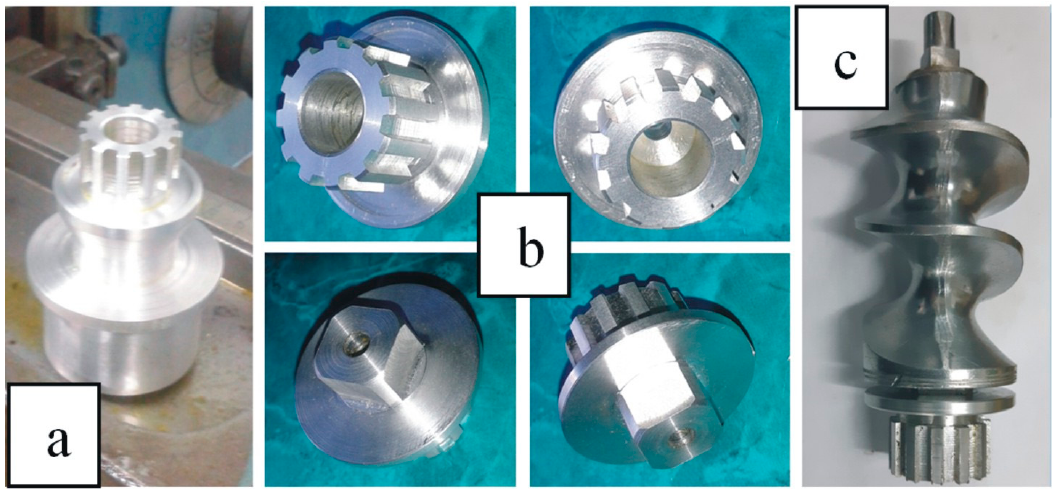
Figure 9. The piece after mortising ( a ), in four hypostases—the finished piece ( b ), the part-mounted piece on the worm ( c ).